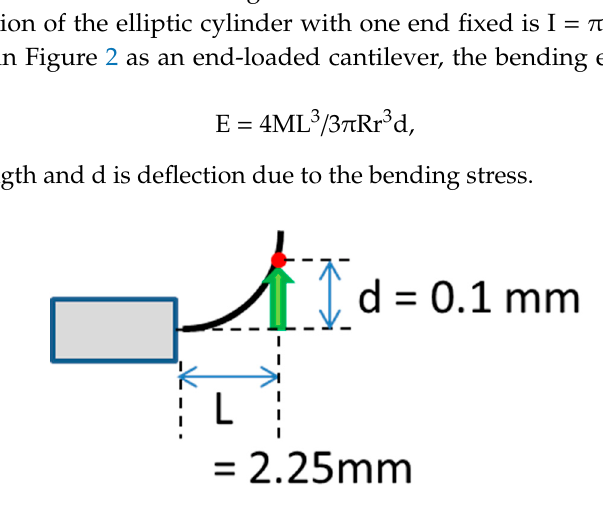
Figure 2. Schematic diagram showing measurement image of bending elastic modulus of hair. L = sample length; d = deflection due to bending stress.